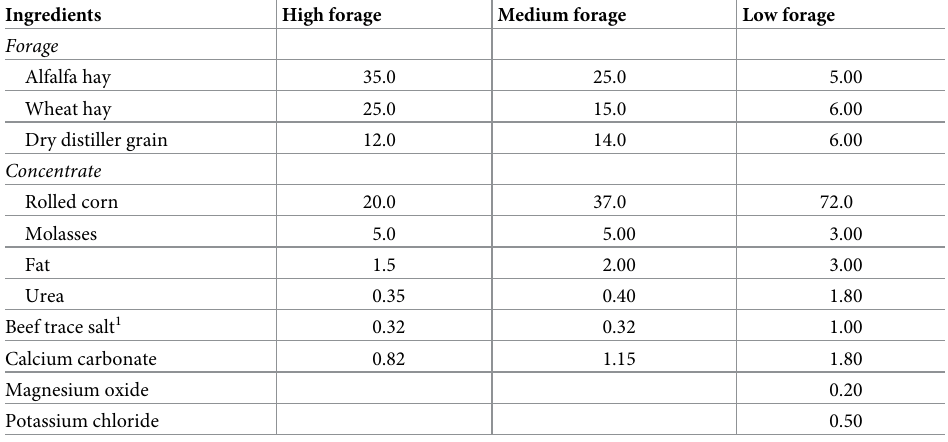
Table 1. Ingredients of the experimental diet containing high, medium, and low forage concentrations (% of DM). Ingredients High forage Medium